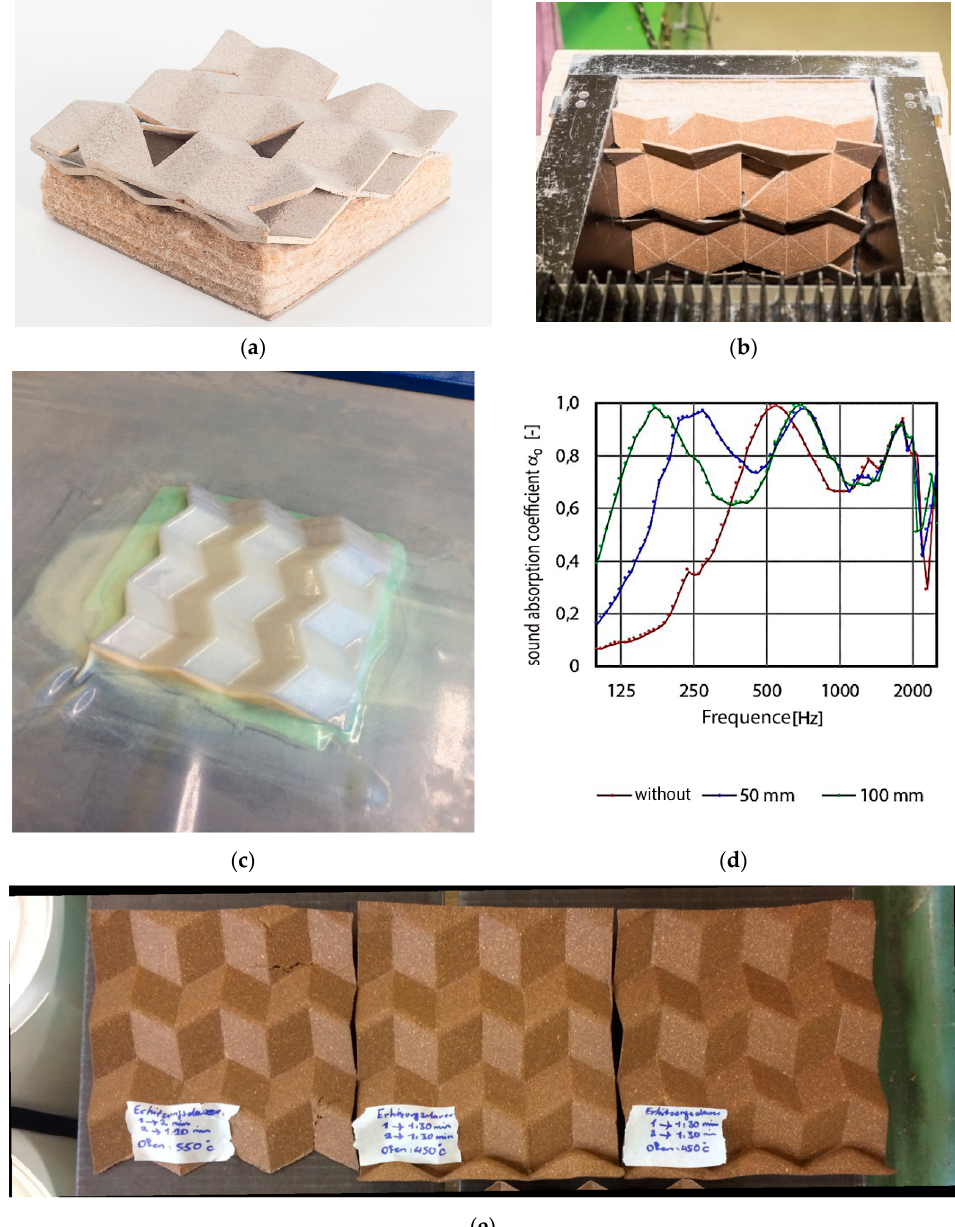
Figure 5. ( a – d ): Illustration of the fabrication methods and the acoustic absorption graph of the Polycal acoustic panel; ( e ): Diverse tests that took place to specify the processing temperature of thermoforming techniques. Photo credit: Banaditsch, Foroutan & Moradian, BioMat-ITKE/University of Stuttgart.